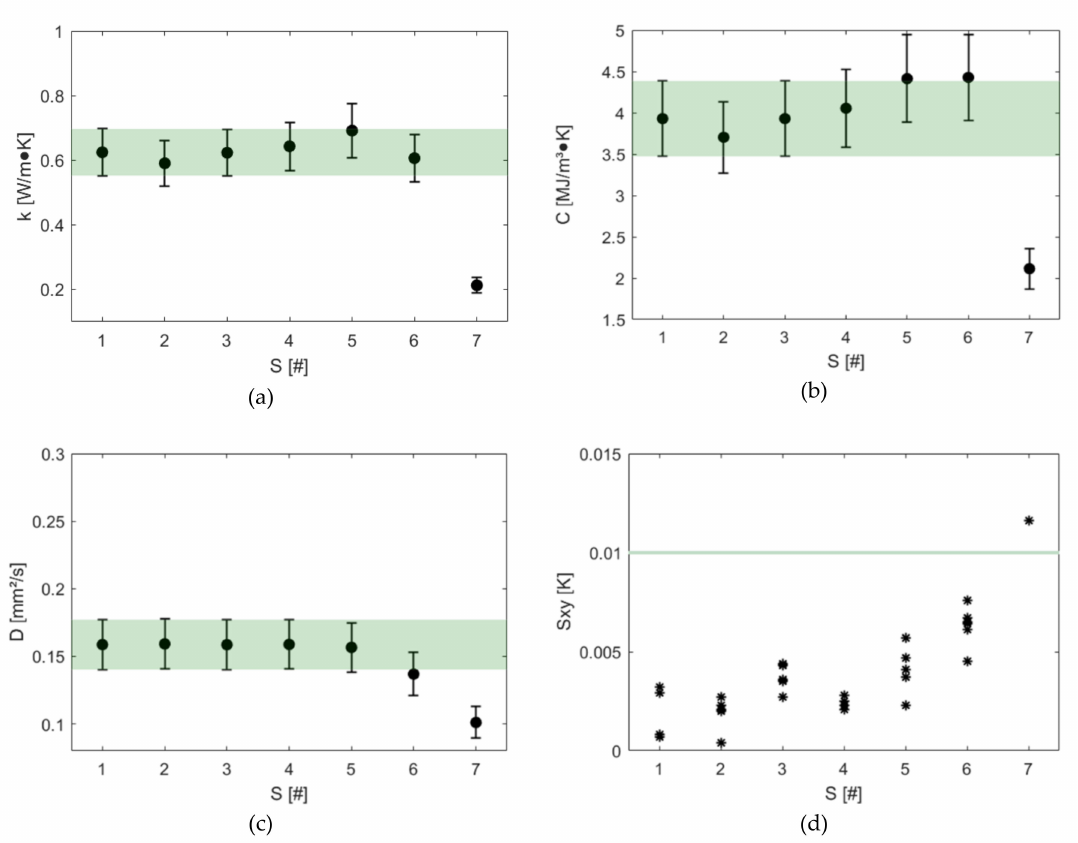
Figure 4. Sensitivity study on the dual-needle sensor: ( a ) thermal conductivity, ( b ) volumetric heat capacity, ( c ) thermal di ff usivity and ( d ) regression error